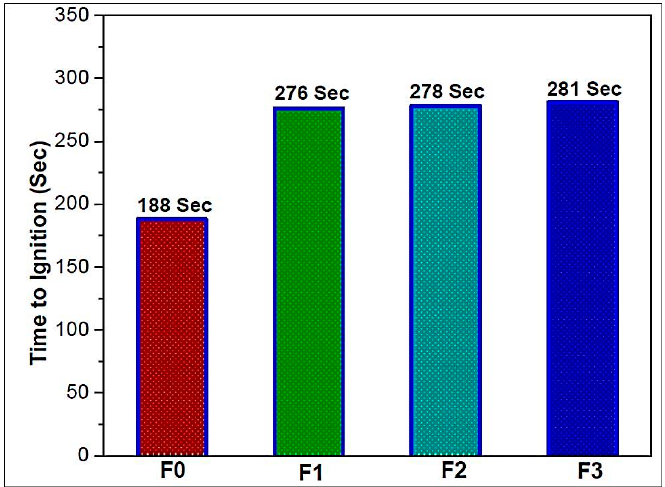
Figure 10. Time to ignition values of the flame retardant samples.